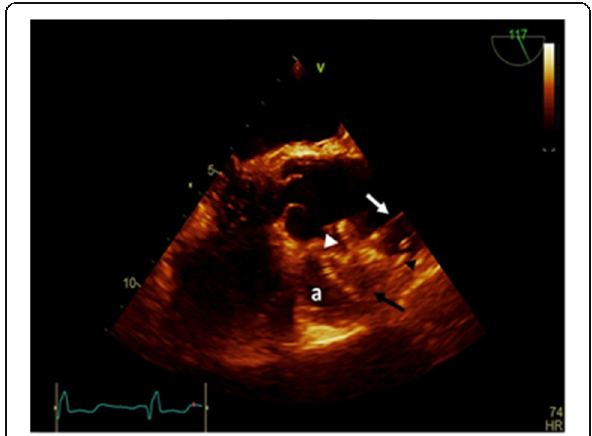
Fig. 5 Inra-opperative Trans-esophageal echocardiography. Completed transcatheter closure of pseudoaneurysm neck with Amplatzer ASD occluder device 18 before it. A pseudoaneurysm.